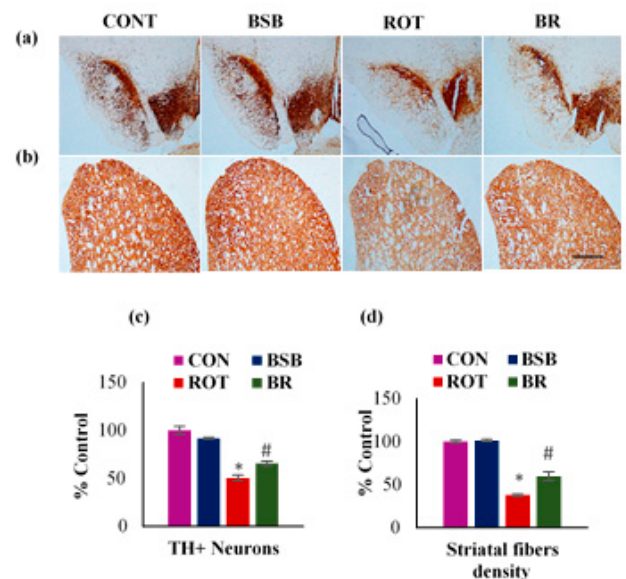
Figure 2. The number of TH-ir neurons and density of TH-ir fibres were determined in the substantia nigra (SNc) and striatum respectively ( a , b ). There was a significant decreased number of TH-ir neurons are found in the ROT injected rats when compared to control rats (CON). However, BSB treatment to ROT injected rats showed a significant increased number of TH-ir neurons compared to ROT alone injected rats (a). Similarly, a significant decrease in the TH-ir striatal fibres expression was observed in ROT injected rats when compared to control rats. Moreover, BSB treatment to ROT injected rats showed enhanced expression of TH-ir fibres in the striatum ( b ). The scale bar is 100 µ m. The quantitative representation of the result of TH-ir neurons in SNc and measurement of TH-ir fibres density are shown ( c , d ). Each group contained three rats and the data were expressed as percent mean ± SEM. * p < 0.05 CON vs ROT; # p < 0.05 ROT vs. BR (One-way ANOVA followed by Tukey’s